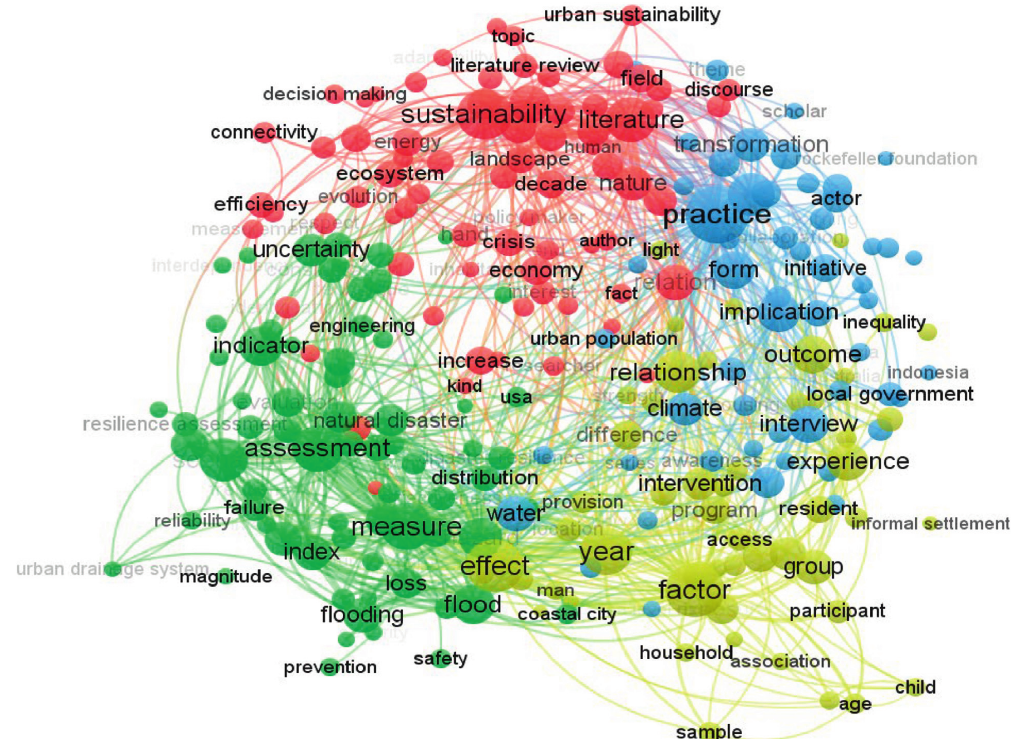
Figure 11: Network visualization map of keyword co-occurrence in resilient city